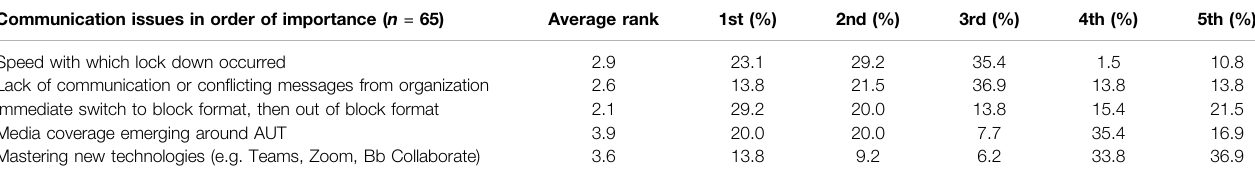
TABLE 2 | Communication issues experienced during the initial